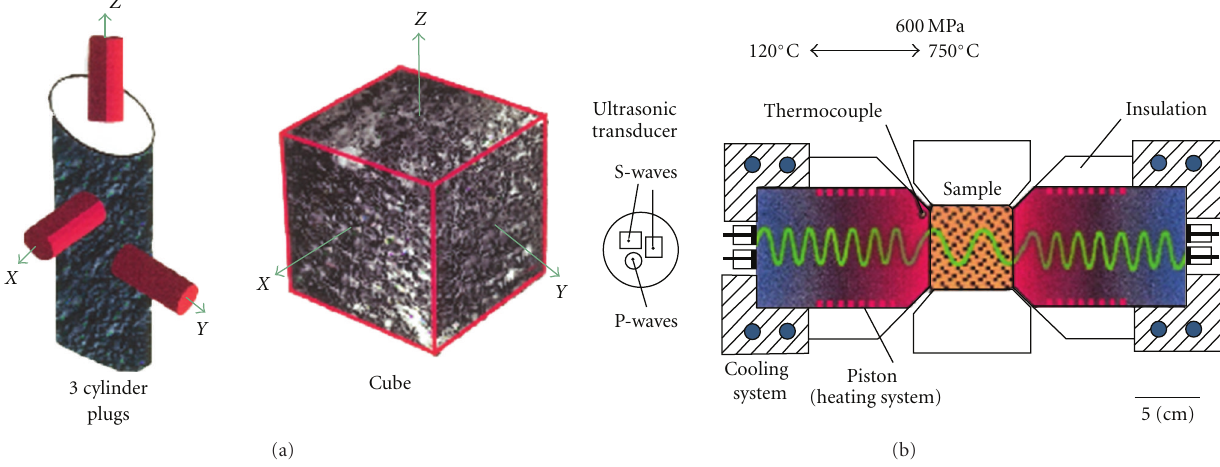
Figure 1: Commonly used sample geometries for laboratory seismic measurements (a) and the piston-sample-transducer arrangement in a multianvil pressure apparatus